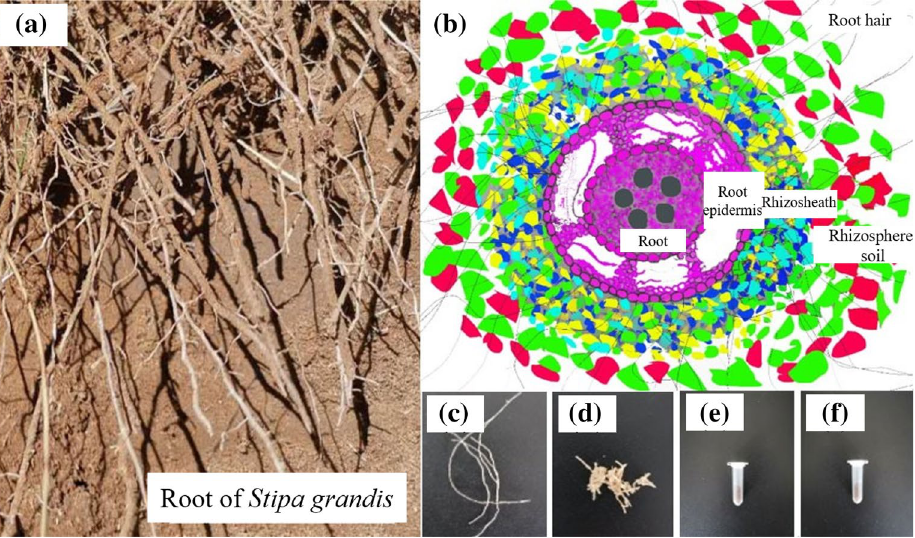
Figure 1. Root system of Stipa grandis and schematic diagram of the root cross section. ( a ) Stipa grandis roots. ( b ) Schematic diagram of the cross section of the root system, and ( c ), ( d ), ( e ) and ( f ) are the root system, root epidermis, rhizosheath and rhizosphere soil,